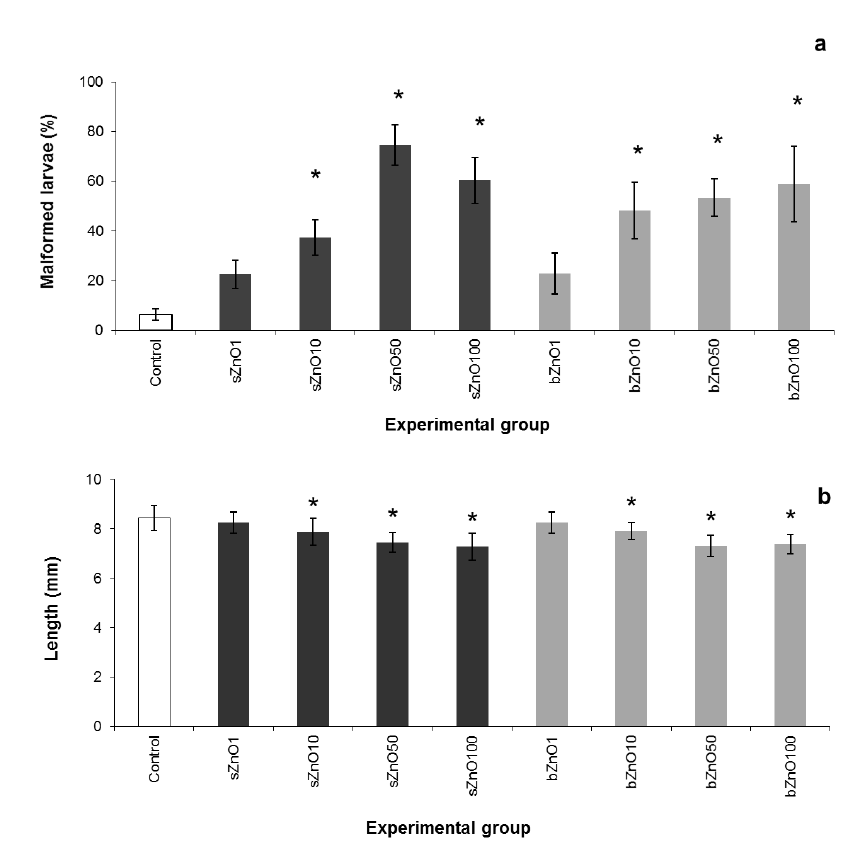
Figure 2. Comparative FETAX results after exposure of embryos to 1–100 mg/L of sZnO and bZnO. ( a ) Malformation rates; ( b ) growth retardation. Dark grey = sZnO-exposed larvae; light grey = bZnO-exposed larvae; bars = SEM; * statistically different from the control ( p < 0.05, ANOVA + Fisher LSD